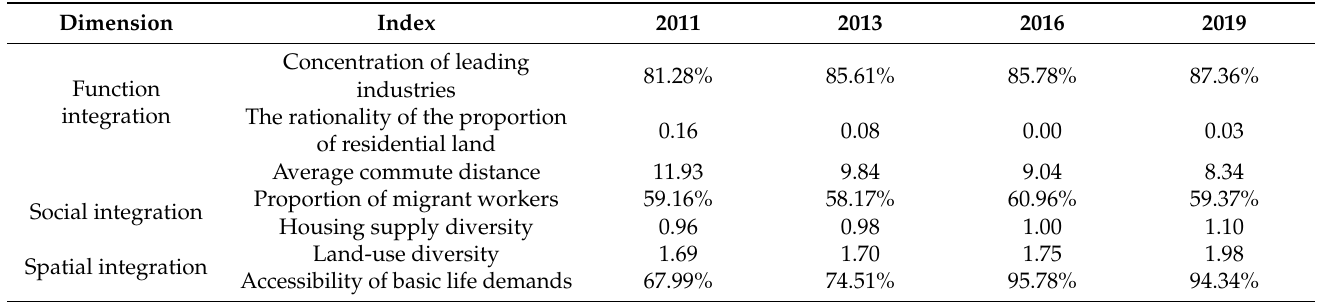
Table 10. Evaluation results for the city–industry integrated development of the Kangqiao indus- trial